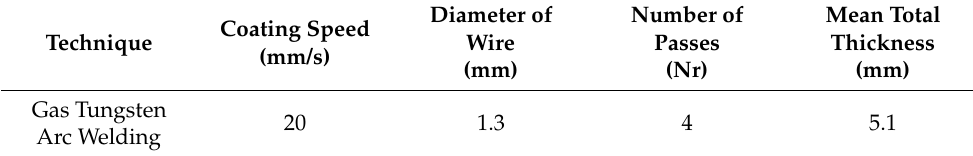
Table 4. Main deposition